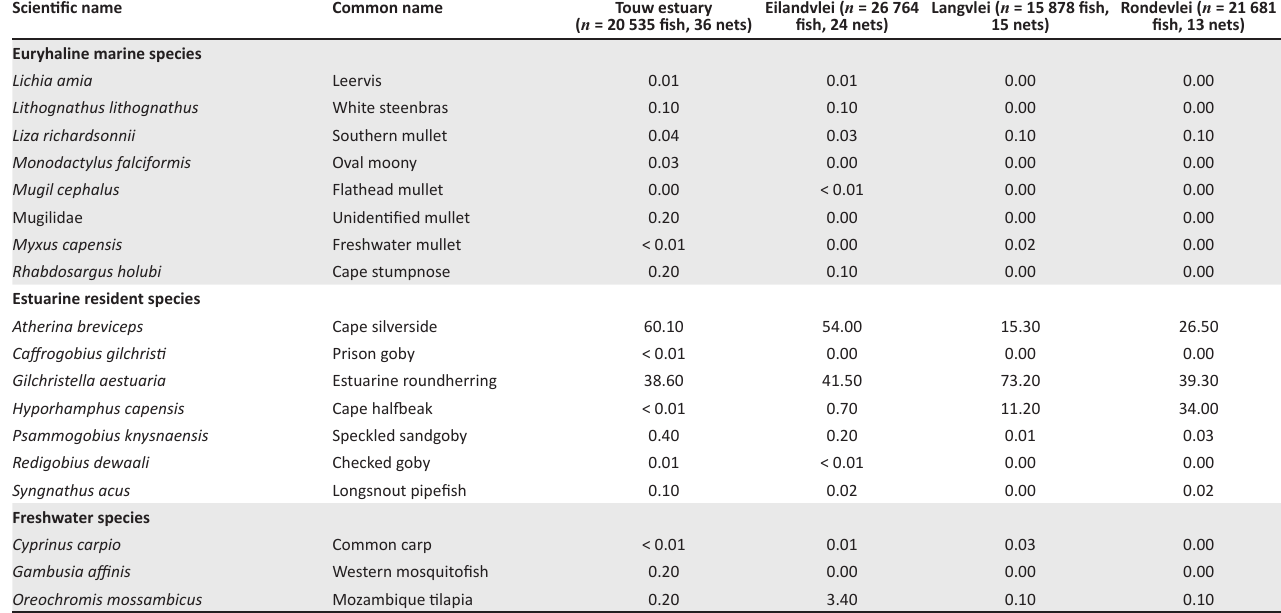
TABLE 1: Relative abundance ( % abundance) of fish species caught in seine nets in the Wilderness Lakes System between April 2010 and January 2011.